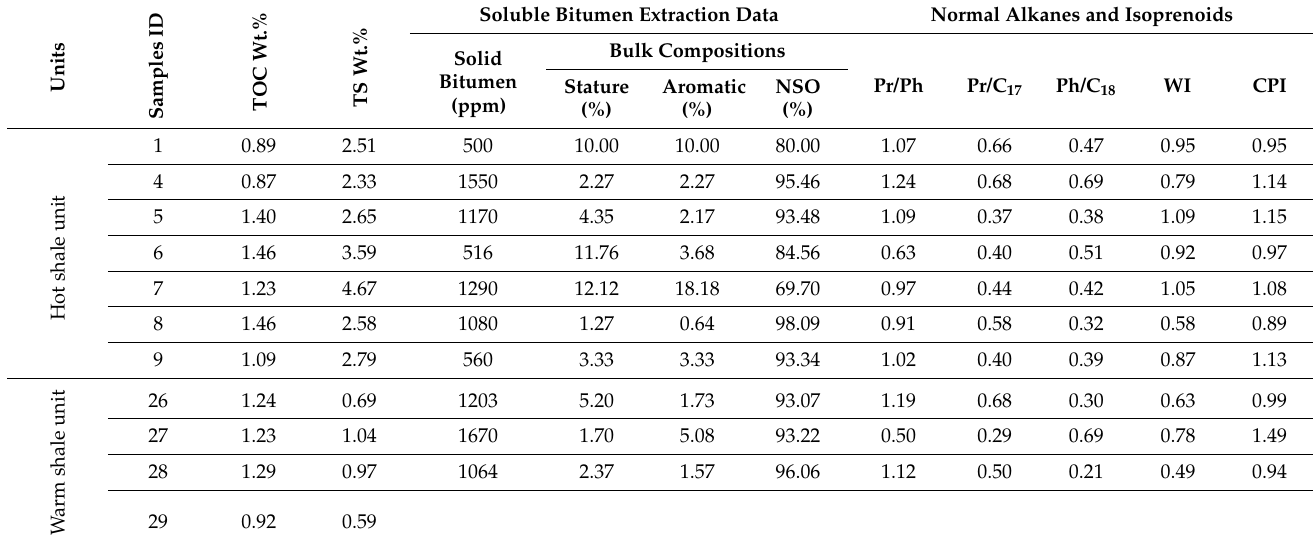
Table 1. Geochemical results of the analyzed dark shales from the Silurian Qusaiba Formation in the Tayma area, Northwestern Saudi Arabia, including TOC and TS contents, soluble bitumen and its bulk compositions as well as distributions of normal alkane and isoprenoid.